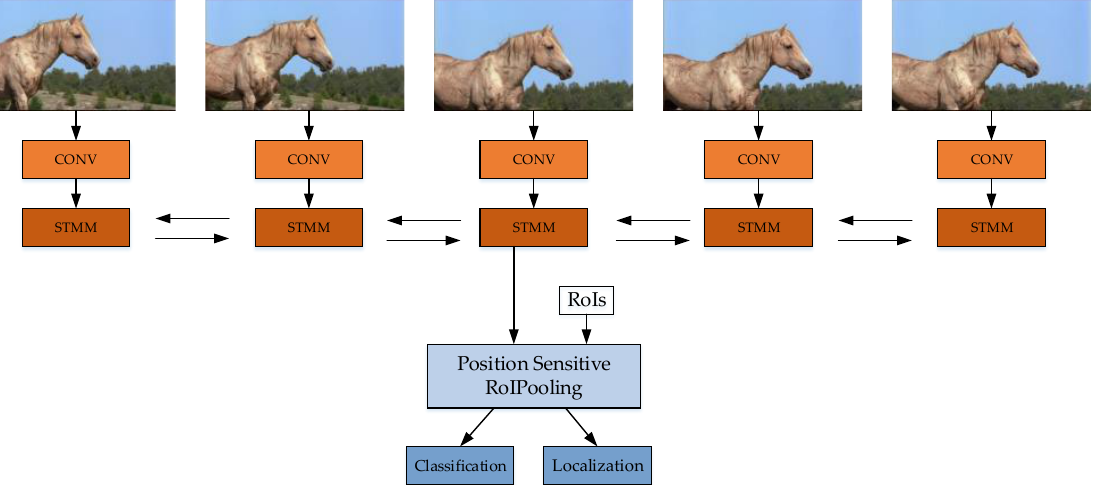
Figure 16. The structure of STMN. Spatial-Temporal Memory Module (STMM) can extract and transmit the spatial-temporal features. STMN does not use the fully connected layer after Position Sensitive RoI Pooling.